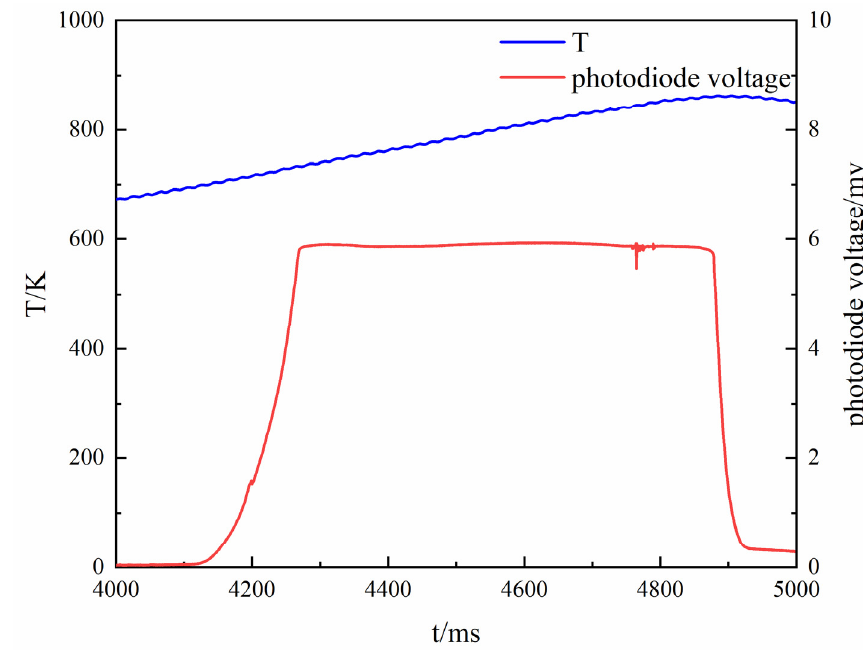
Figure 4. The ignition temperature curves of Mg powder.